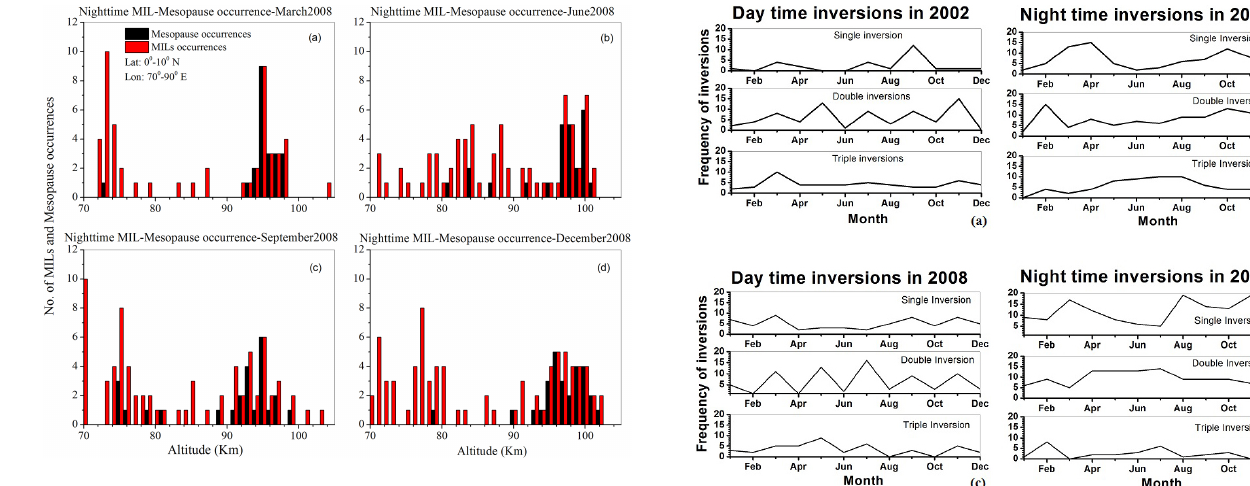
Figure 4. As Fig. 3, but for the night-time measurements.